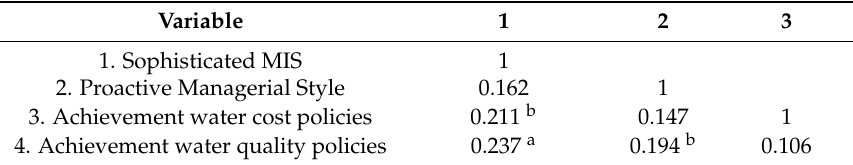
Table 2. Correlations among variables.